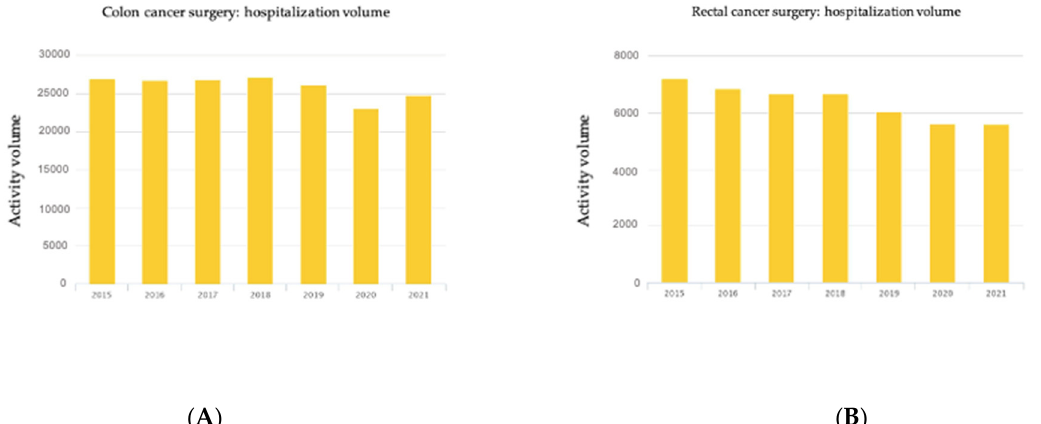
Figure 1. Hospitalization volume for colon cancer ( A ) and rectal cancer ( B ) in Italy according to PNE 2021 [11]. 2021